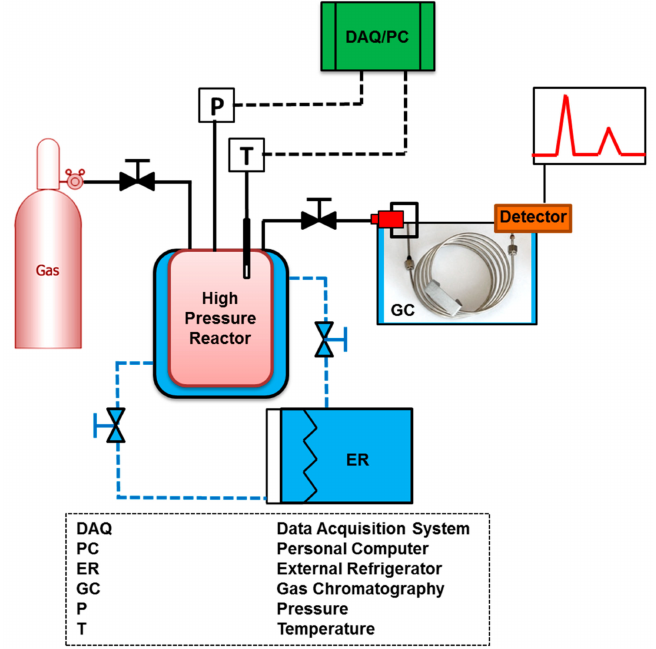
Figure 1. Schematic diagram of the experimental